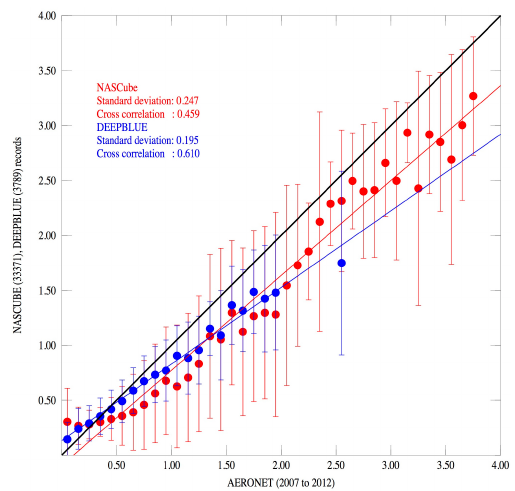
Figure 12. Comparison of Deep Blue 0.550 µm (blue), NASCube 0.550 µm (red) AOD retrievals to AERONET 0.440 µm during 2007–2012. The dots represent the mean values and the error bars the standard deviations computed for AERONET AOD values split in classes of 0.1.